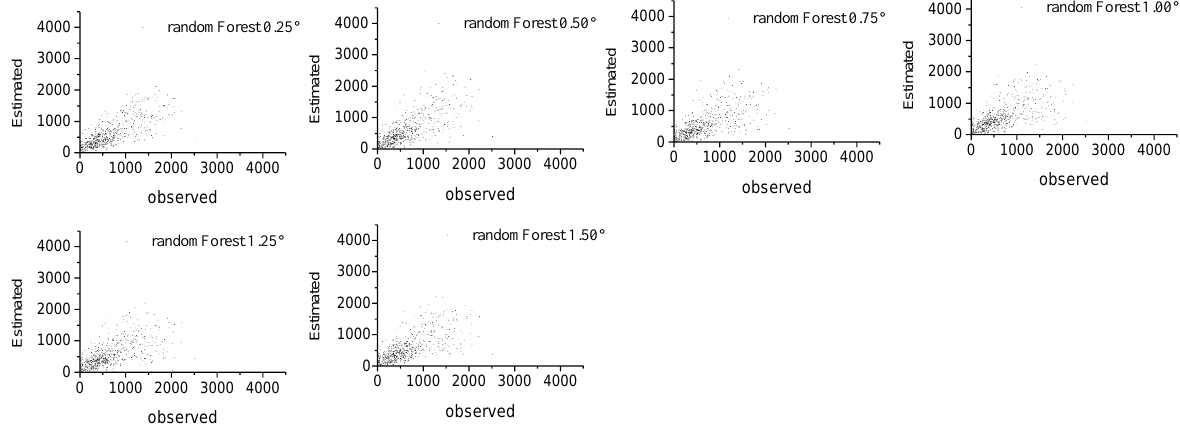
Figure A4. Scatter plot of the measured annual precipitation from 596 meteorology stations versus the predicted precipitation extracted from the final downscaled using the multiple linear regression models, exponential models, and random forest models built at spatial resolutions of 0.25°, 0.50°, 0.75°, 1.0°, 1.25°, and 1.50°, respectively, for the year 2001 over China mainland without gap-filling processing.